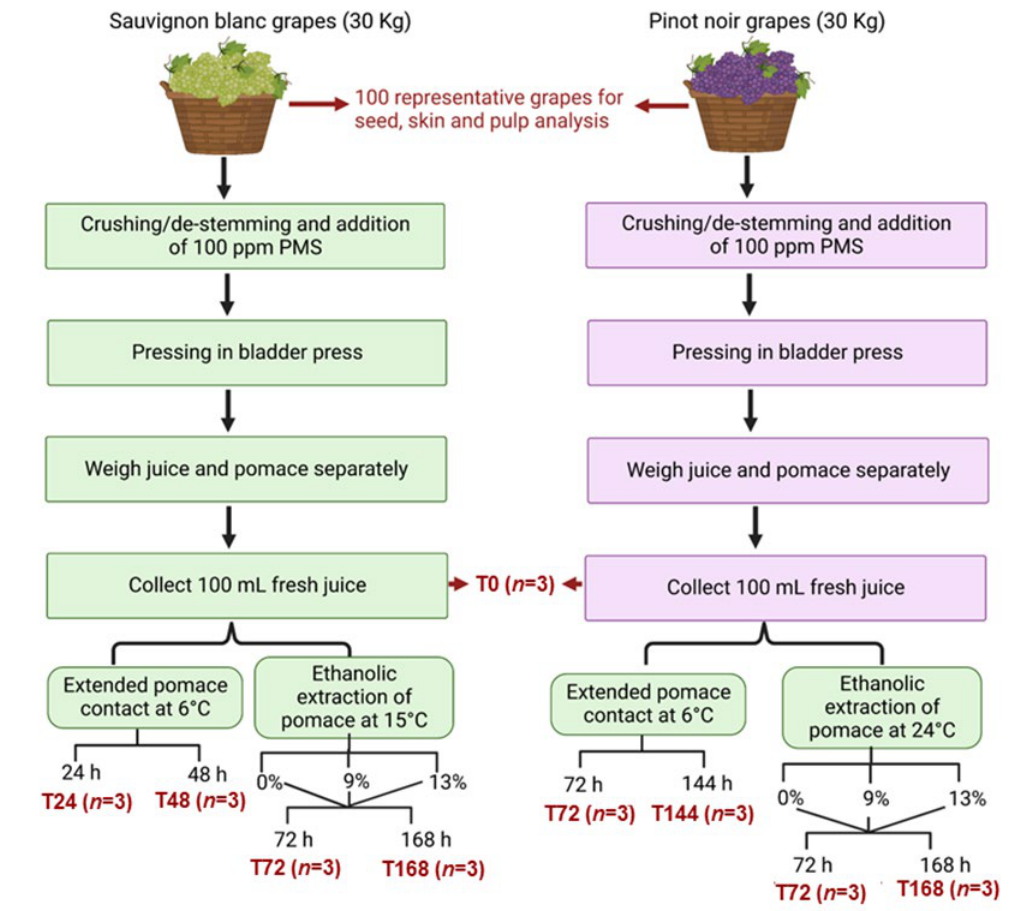
Figure 1. Sample preparation protocol for the project. Here, PMS = potassium metabisulphite, T0 = fresh juices without pomace contact. T denotes the time of pomace contact, number of samples from each stage is shown in red. Green represents Sauvignon blanc while purple shows Pinot noir sampling method. The total number of samples was 122.